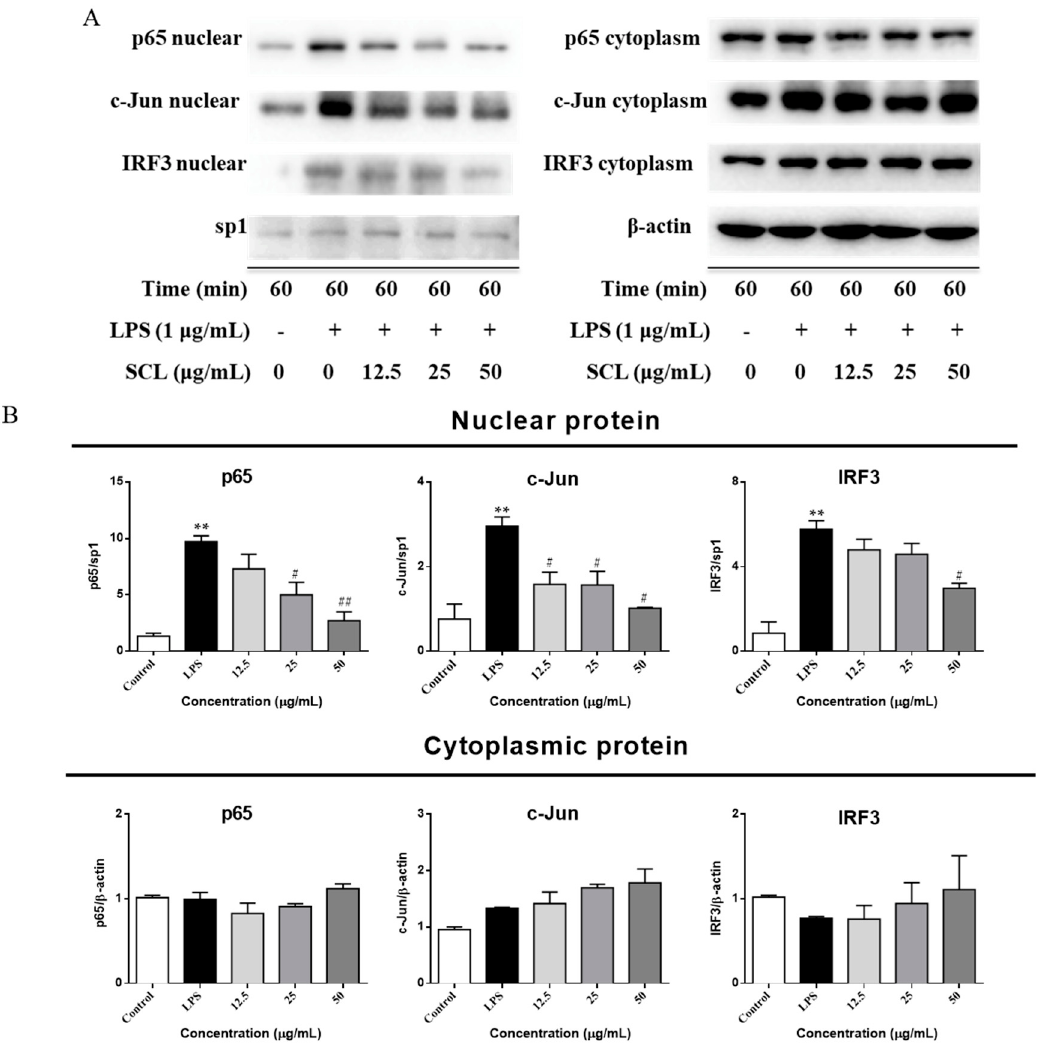
Figure 7. Effect of SCL on the nuclear and cytoplasmic protein levels of NF- κ B, AP-1 and IRF3 in LPS-stimulated RAW264.7 cells. Cells were pre-treated with SCL in different concentrations as indicated for 1 h and then stimulated with LPS for 60 min. The cytoplasmic and nuclear protein levels of NF- κ B (p65), AP-1 (c-Jun), and IRF3 were determined by Western blotting ( A ). Bar graphs show the relative levels of cytoplasmic and nuclear p65, IRF3, and c-Jun ( B ). Values given are the mean ± SEM of 3 independent experiments. ** p < 0.01 vs. unstimulated cells. # p < 0.05, ## p <0.01 vs. LPS-stimulated cells using a one-way ANOVA followed by Dunnett’s multiple comparisons test.